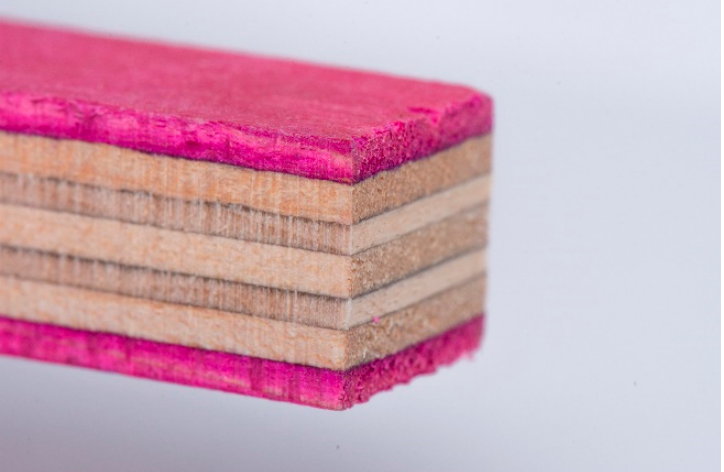
Figure 7. Face Wise Strip Orientation.